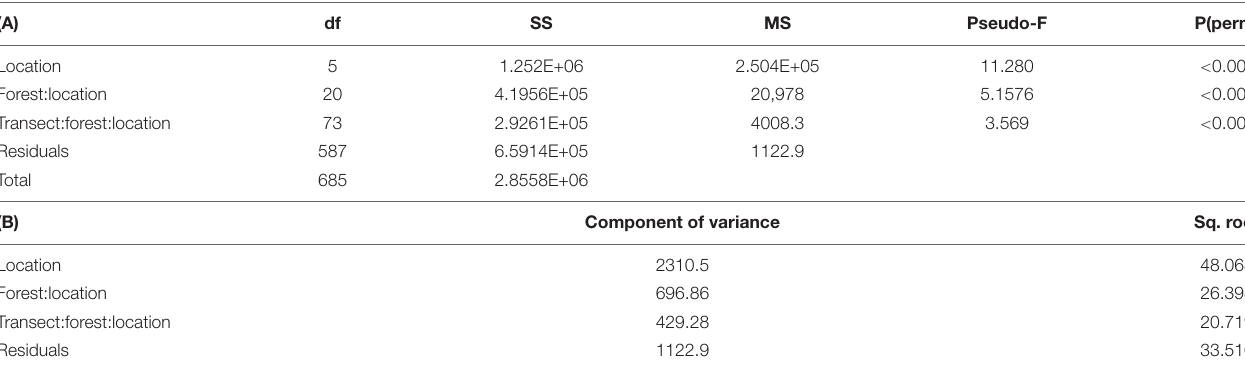
TABLE 2 | Permutational Analysis of Variance (PERMANOVA) of fucalean species percentage cover between locations (random), forests (random, nested within locations), and transects (random, nested within forests and locations) (A) , and the components of variance (B)